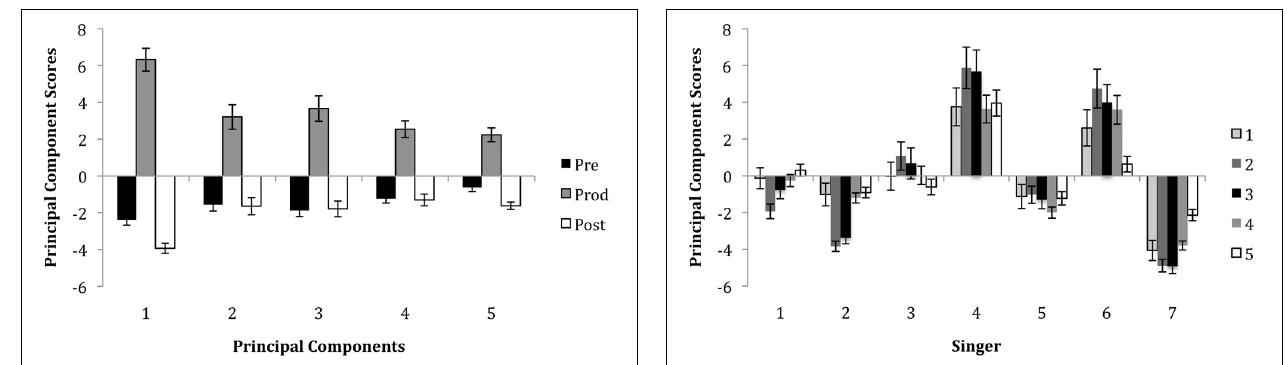
FIGURE 3 | The average principal component scores for each epoch. Error bars represent standard errors.